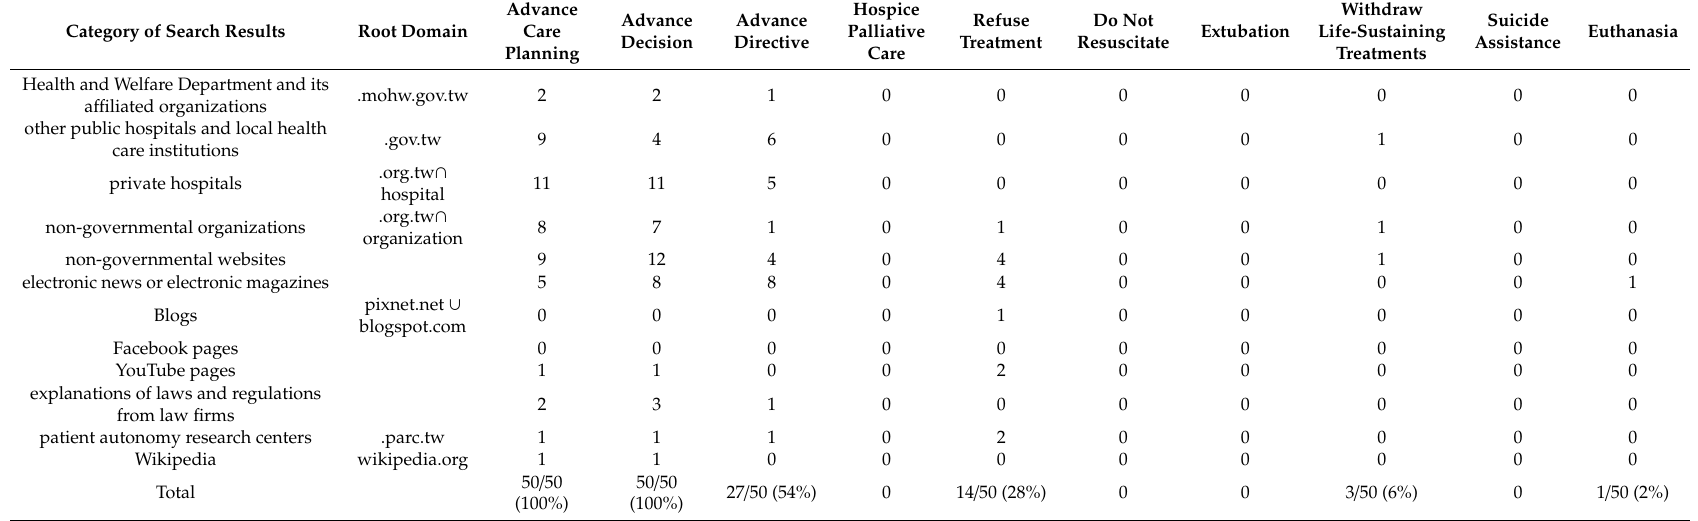
Table 1. The number of search results for each of the di ff erent terms that were related to the Patient Autonomy Act when searching with the Google search engine on 5 January